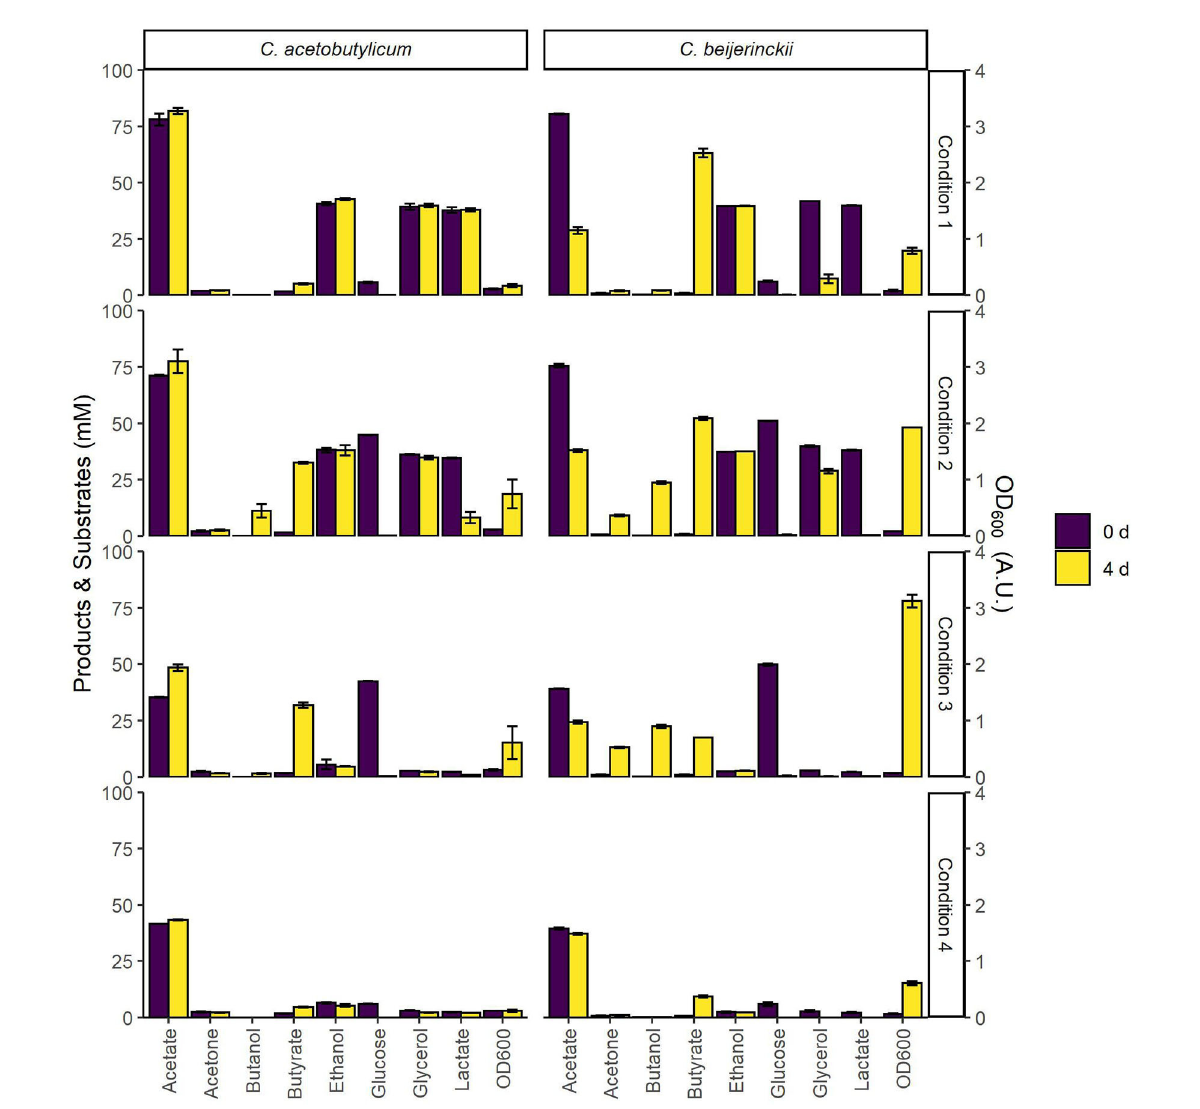
FIGURE4 Initial screening of C. beijerinckii and C. acetobutylicum for growth on various combinations of carbon sources. The bars indicate substrate and product concentrations, and cell density at the time of inoculation and after 4 days. CM2 medium, containing 38 mM acetate, was supplemented with 40 mM of each of the various carbon sources as follows: Condition 1: acetic acid, ethanol, glycerol, and L -lactic acid; Condition 2: acetic acid, ethanol, glycerol, L -lactic acid and glucose; Condition 3: glucose. Condition 4: none. Error bars show standard deviations between two cultures inoculated with the same